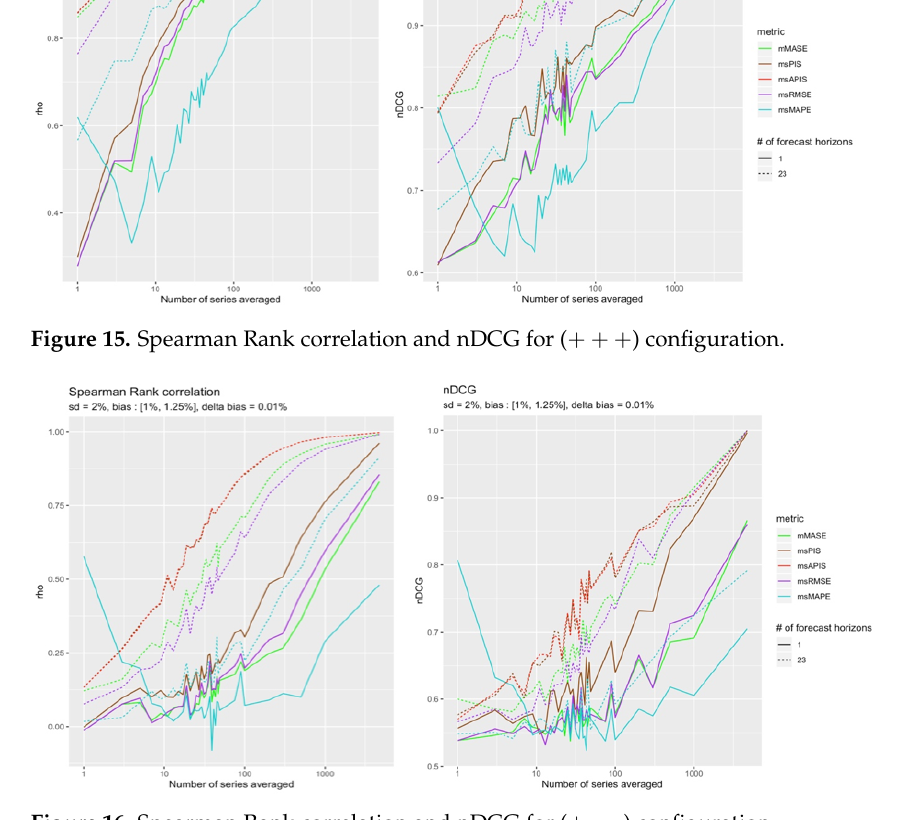
Figure 16. Spearman Rank correlation and nDCG for ( + −− ) configuration.